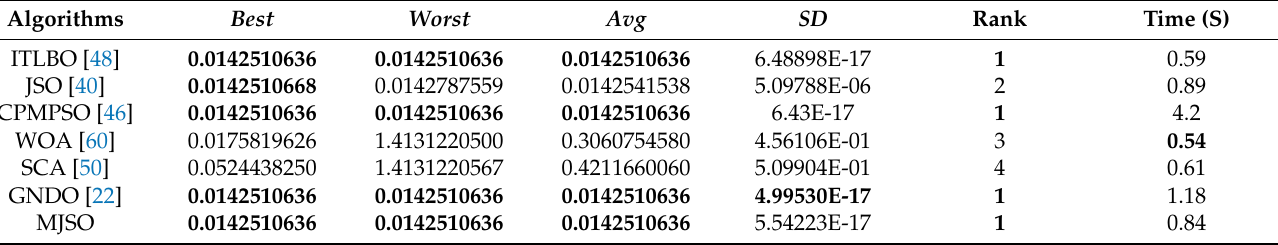
Table 13. Comparison of the STP6-120/36 module.